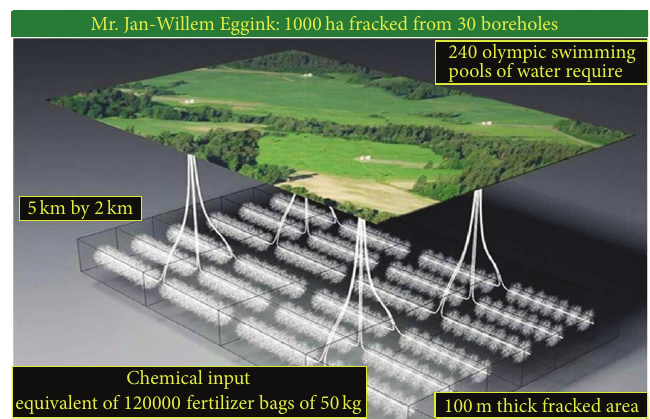
Figure 3: Example of fracking area